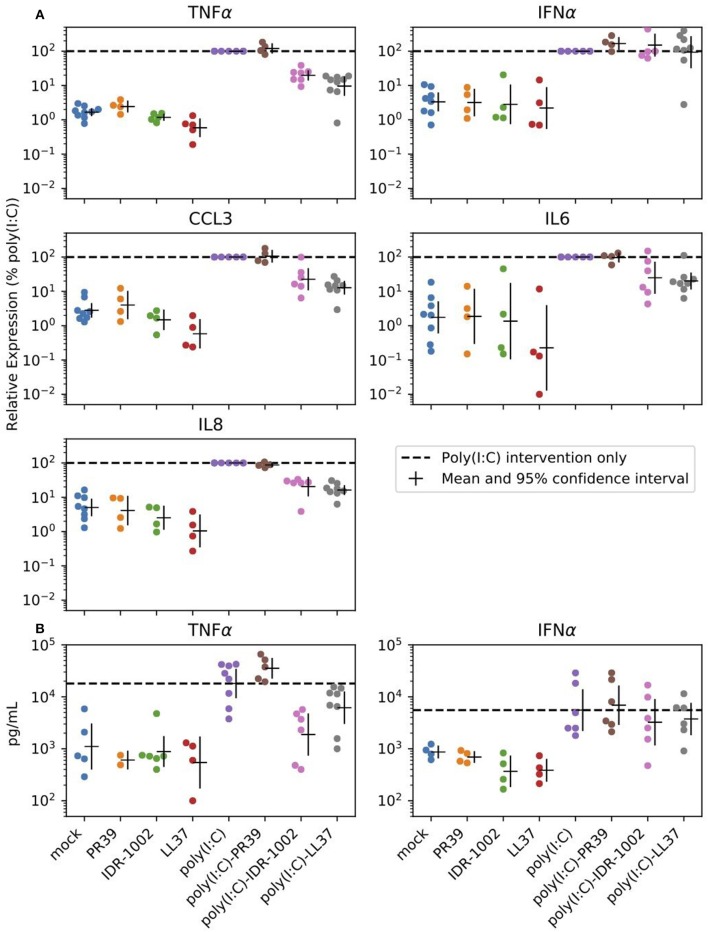
Peptide reduction of poly(I:C)-induced response. Selected peptides can reduce expression of poly(I:C) induced inflammatory cytokines in alveolar macrophages. Cells were stimulated with the positive control poly(I:C) (10 μg/mL), the HDPs (20 μg/mL) or a combination of both. (A) Transcript expression was analyzed 6 h after stimulation. (B) Cell supernatants were analyzed by ELISA to determine the production of TNFα and IFNα after 24 h of stimulation of the alveolar macrophages. Each group includes 4 to 8 pigs and estimated means with 95% confidence intervals are presented. The horizontal dashed line marks poly(I:C) intervention only (For statistical analysis please see Table 2).